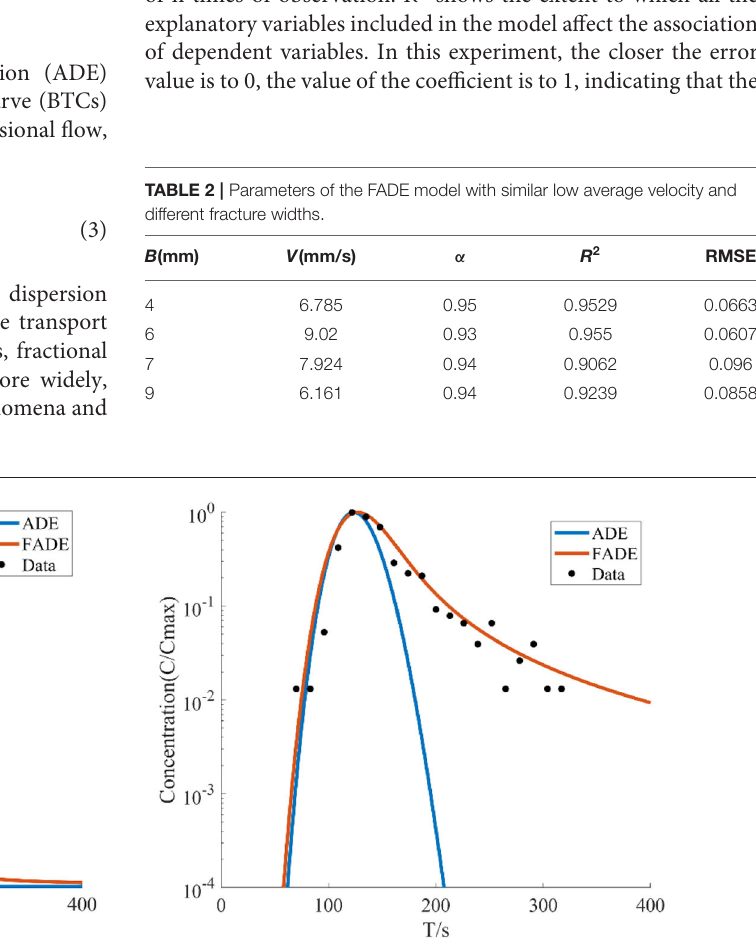
FIGURE 7 | The average flow velocity is v = 6.161 mm/s, the crack width is B = 9mm, the BTCs are fitted by ADE model and FADE model.